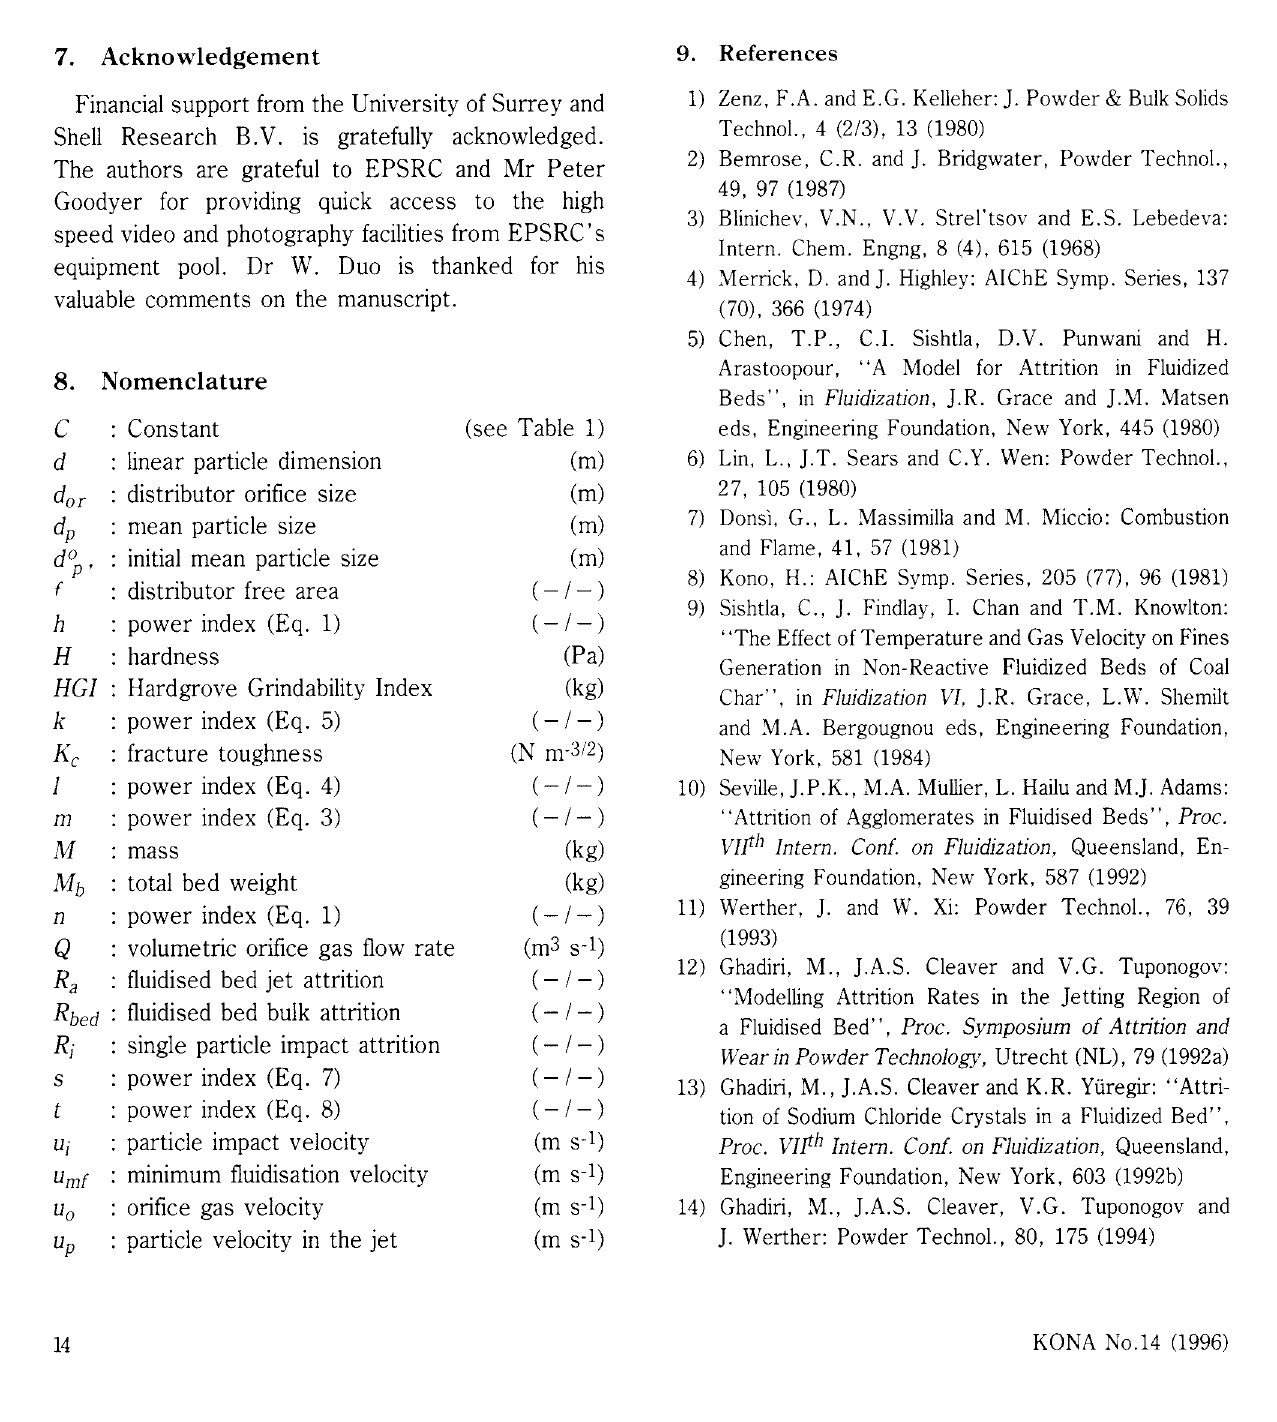
Fig. 13 Time dependent attrition rate of common PO\' salt in a jetting fluidised bed